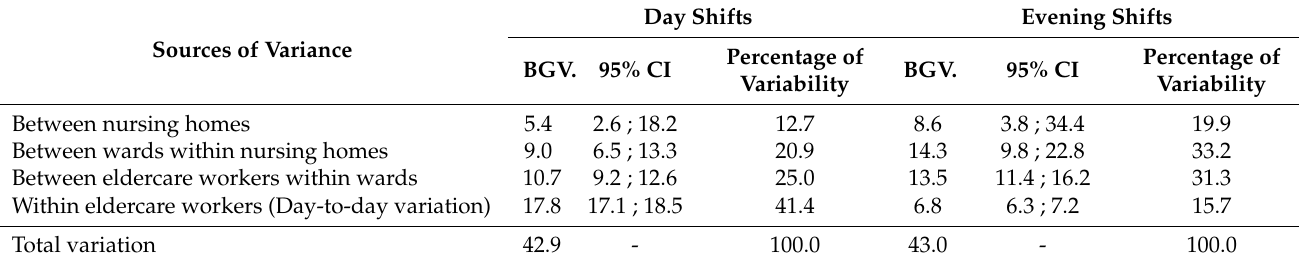
Table 3. Estimated contribution of different sources of variance to the total variability in number of resident handlings performed per shift in eldercare work stratified on day (N = 5572) and evening shifts (N = 2373) work. (BGV. = Between Group Variance; 95% CI = 95% confidence